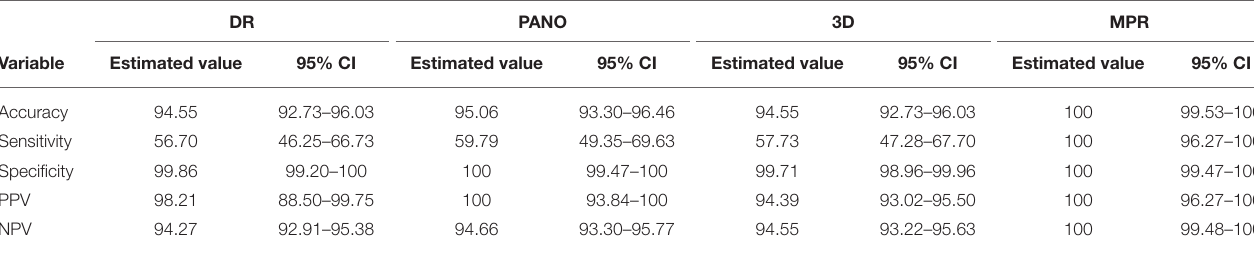
TABLE 12 | Ability to identify feline resorptive lesions in cats by use of dental radiography (DR method) and 3 CBCT software modules *